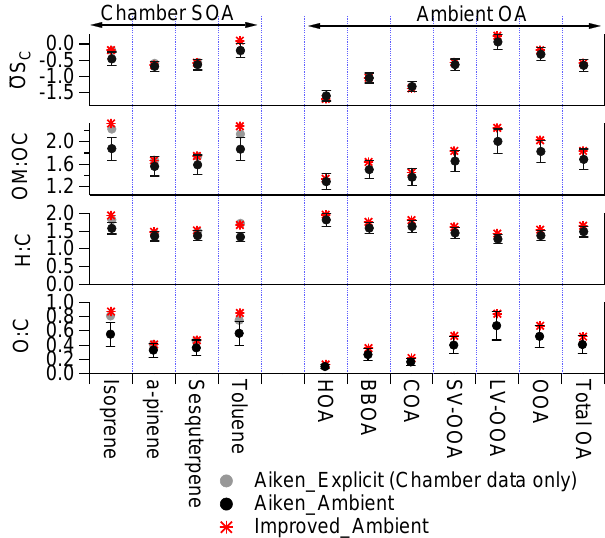
Figure 7. Summary of elemental composition information obtained across chamber and ambient OA measurements. The figure shows values obtained with the Improved-Ambient method as well as the Aiken-Ambient method. Aiken-Ambient elemental ratios are shown with errors from Aiken et al. (2007, 2008) for reference. For the chamber data, Aiken-Explicit values measured by Chen et al. (2011) and Hildebrandt Ruiz et al. (2014) are also shown. The elemental composition information shown for ambient OA is averaged over the data sets shown in Table S1 and S2 in the